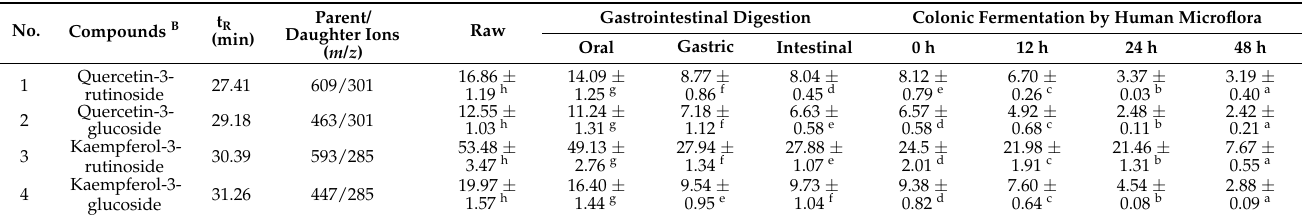
Table 2. Identification and quantification of the major phenolics in THR extract during the in vitro gastrointestinal digestion and colonic fermentation by human microflora A